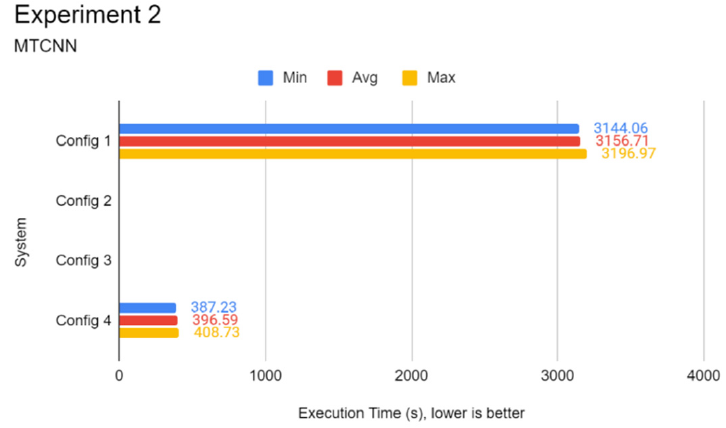
Figure A4. Bar chart execution time results for all systems running MobileNetV3 on CIFAR10 in Experiment 1. Configurations 2 and 3 are excluded due to Spark OOM error.